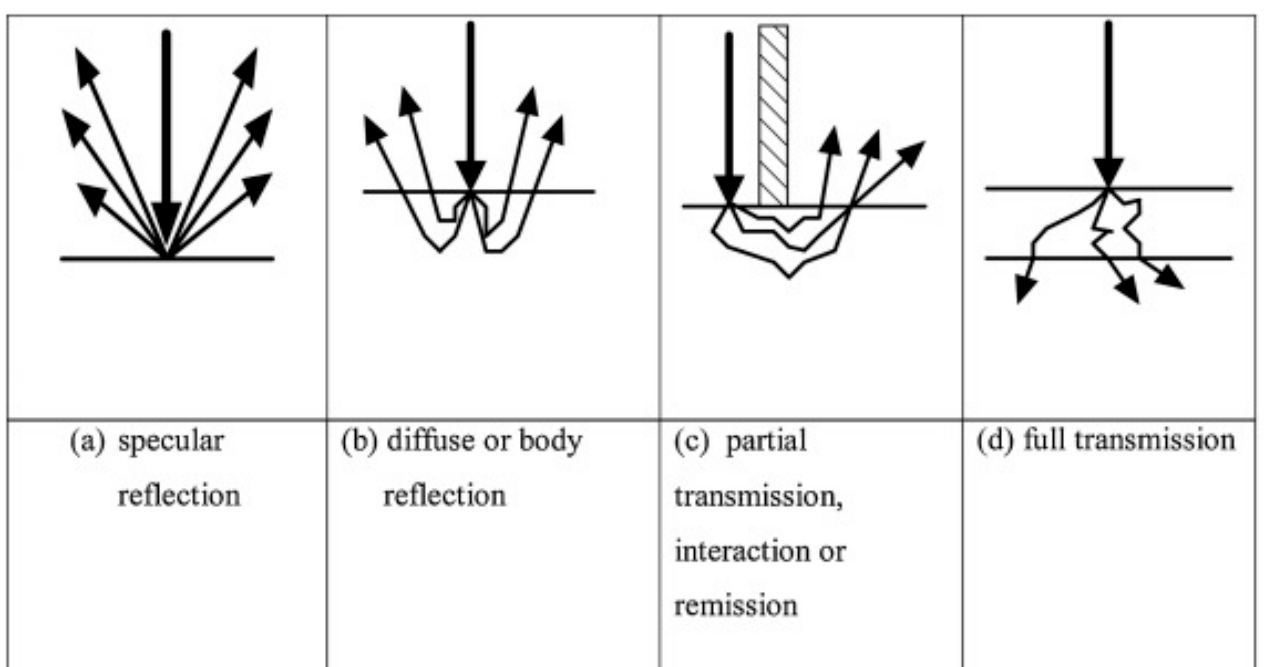
Figure 3. Sample presentation modes used in the infrared spectroscopy analysis of solid materials, showing the interaction of the light with the sample. The arrows indicate representative light paths, with respect to the material being analysed. Reproduced from Walsh et al. [4] under Creative Commons 4.0 licence.